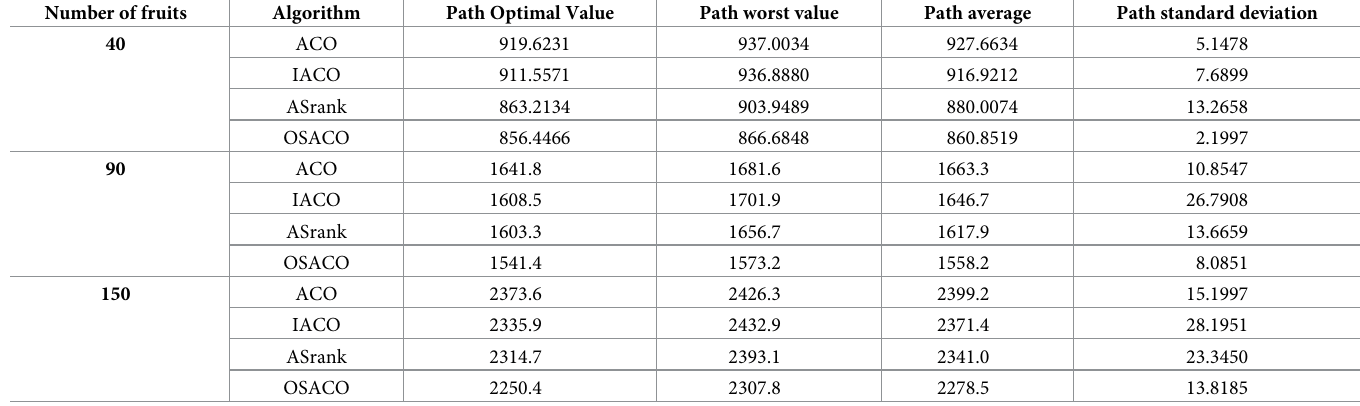
Table 2. List of test results.